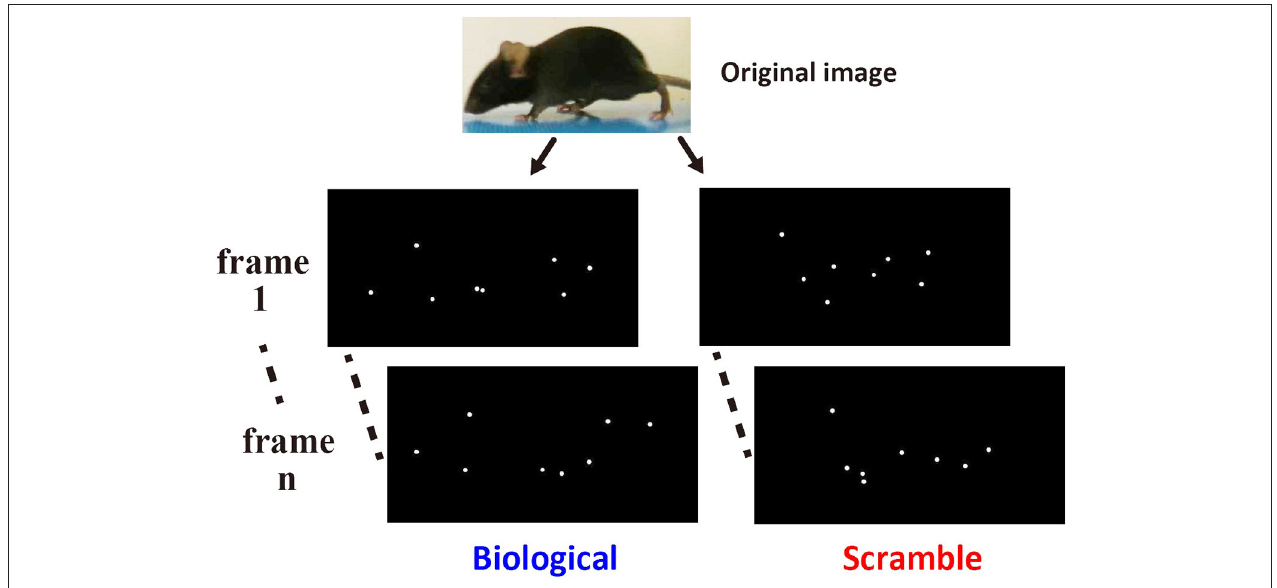
FIGURE 1 | Example of the stimuli used in the Movie test. The left images show two non-successive frames from a point-light animation sequence depicting normal biological motion extracted from an original video clip (top). The right images show the corresponding frames from an animation containing the same dots undergoing the same local motions, only with their initial start locations